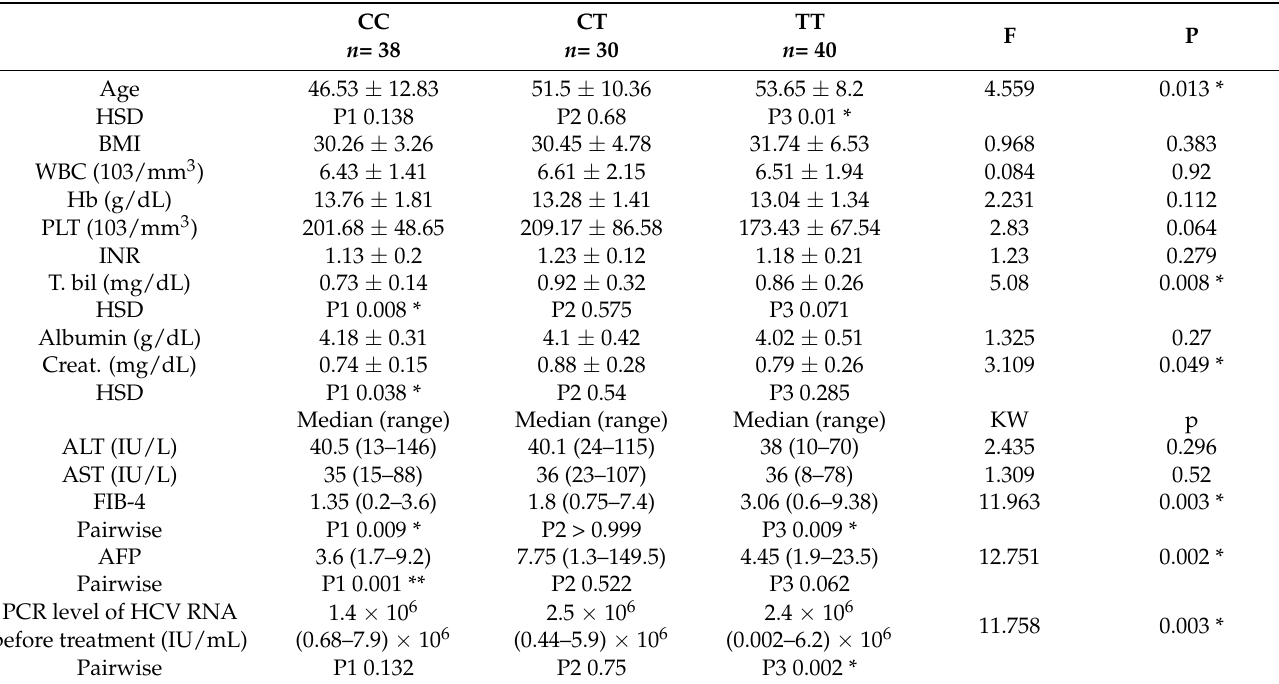
Table 4. The relation between IL28B (rs12979860) genotype, demographics, and laboratory parameters.